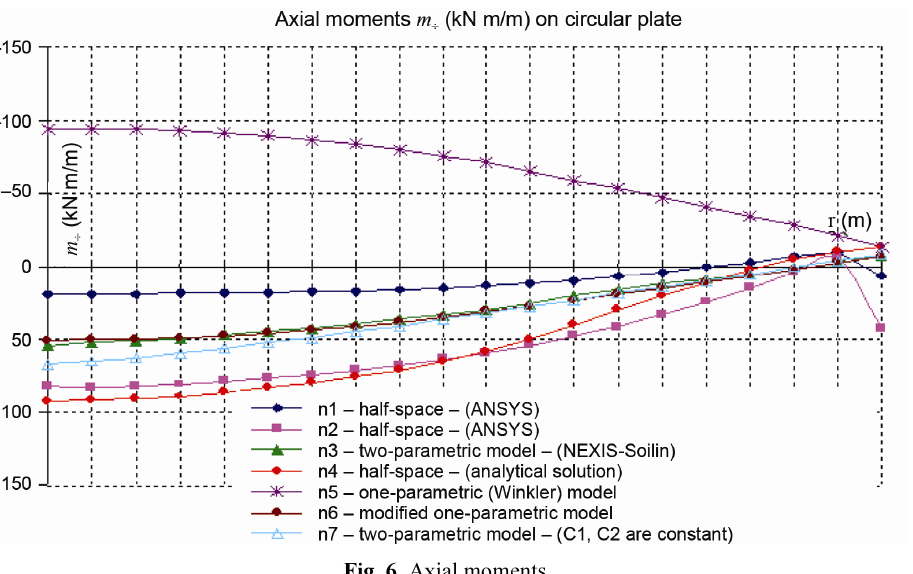
Fig. 6. Axial moments